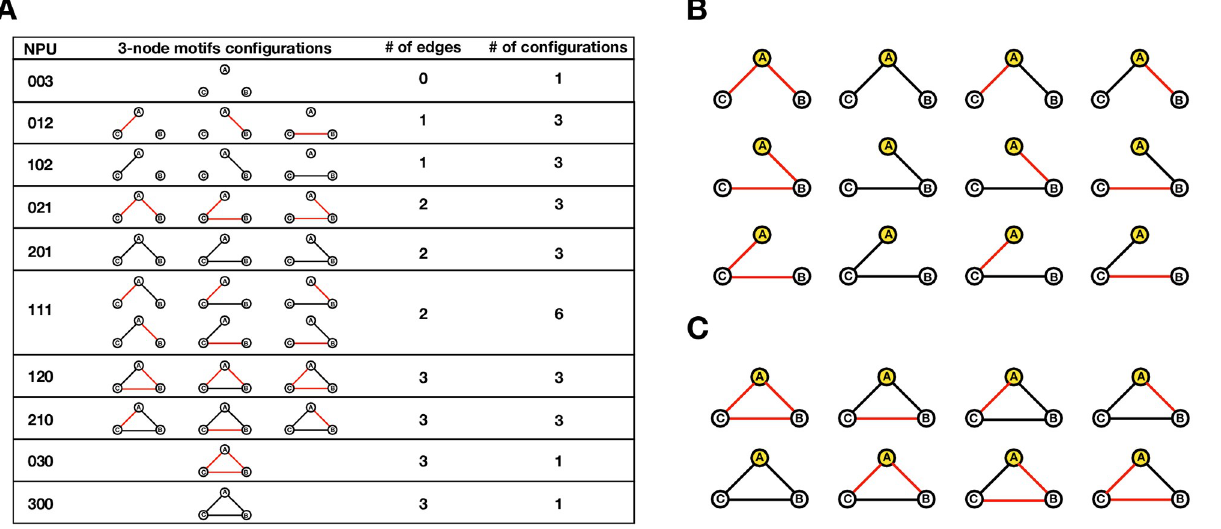
Fig 7. Classification of 3-node motifs adopted from the triad census proposed by Davis and Leinhardt [37]. Nodes are labelled A, B, C clockwise to represent non-redundant NRs. Edges are illustrated as positive correlations (stronger than +1.0%) in red or as negative correlations (stronger than -1.0%) in black. (A) The 27 NPU configurations of non-redundant nodes. (B) The 12 configurations of the linear motifs based on the position of the hub (labelled A and in yellow). Top row: node A is connected to both B and C. Middle row: node A is connected to C via B. Bottom row: node A is connected to B via C. (C) The 8 configurations of the non-redundant complete 3-node network motifs. These motifs are divided into two groups based on the position of the hub (labelled A and in yellow). Top row: Node A and associated nodes B and C and are considered to have coherent behaviour. Bottom row: Node A and associated nodes B and C and are considered to have incoherent behaviour.